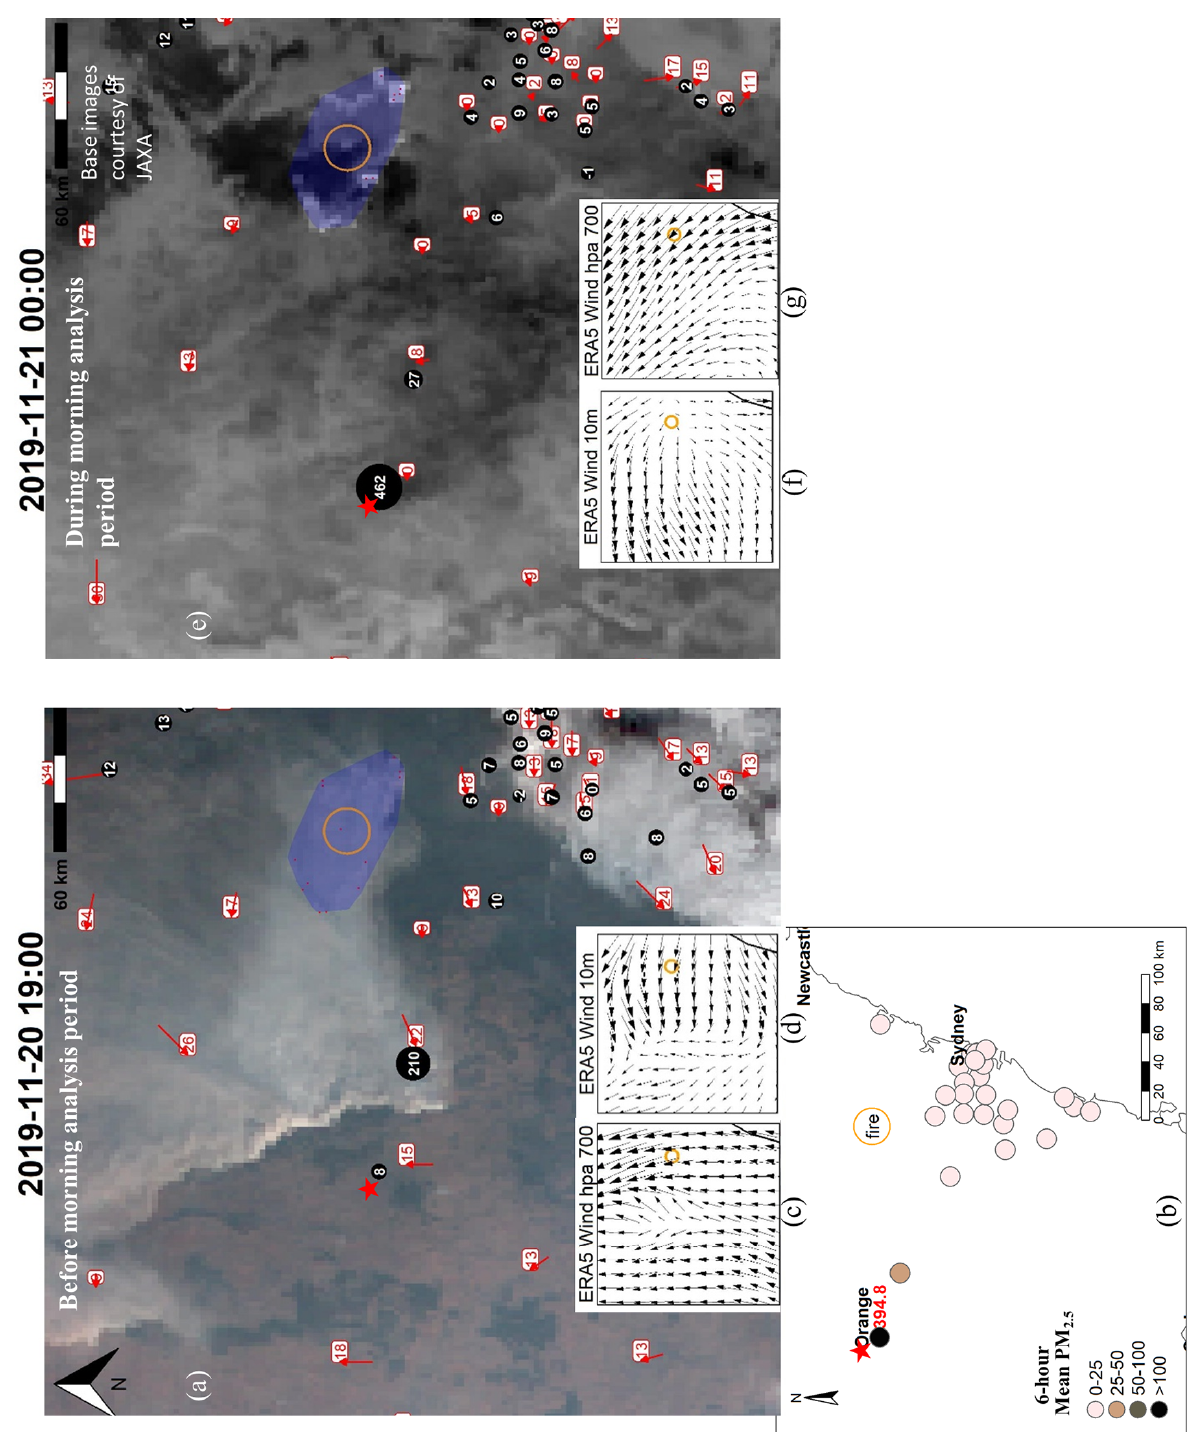
Figure A3. Wildfire night. The highest mean night WF PM 2 . 5 was 394.8µgm − 3 at Orange (red star), also from the Gospers Mountain fire. All except one other AQS (Bathurst 25–50µgm − 3 ) had mean PM 2 . 5 < 25µgm − 3 for this period (b) . At midnight (e) the smoke appears to be flowing directly from the fire to Orange (PM 2 . 5 = 462µgm − 3 ), given no AQSs in Sydney (SE of fire) had high PM 2 . 5 and there were easterly 10m winds (f) . This example shows that smoke circulation can be complex. At 19:00AEST, 1h before our “night” period here, there were easterlies at the fire but Orange AQS had southerlies (a) . The easterlies had only reached Bathurst (PM 2 . 5 = 210µgm − 3 ) and not Orange (PM 2 . 5 = 8µgm − 3 ). Later (e) the easterlies reached Orange along with the surface smoke, resulting in high PM 2 . 5 . On the day after this, winds switched to northerlies and PM 2 . 5 rose substantially across Sydney and in